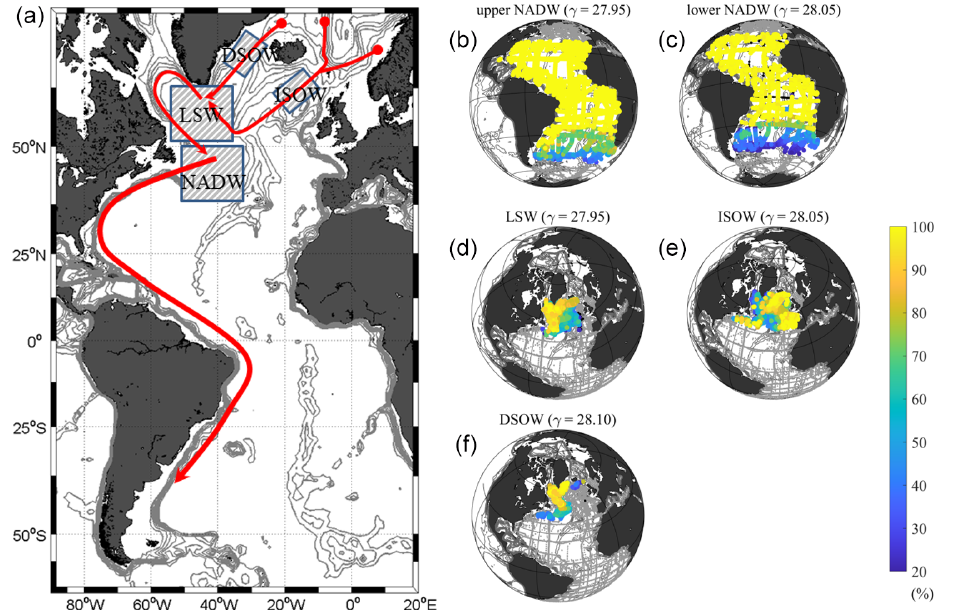
Figure 12. Currents (a) and water masses (b, c, d, e, f) in the deep and overflow layer. (a) The currents (arrows) and the formation areas (rectangular shadows) of water masses in the deep and overflow layer. (b, c, d, e, f) The coloured dots show fractions (from 20% to 100%) of water masses in each station around core neutral density (kgm − 3 ). Stations with fractions less than 20% are marked by black dots, while grey dots show all the GLODAPv2